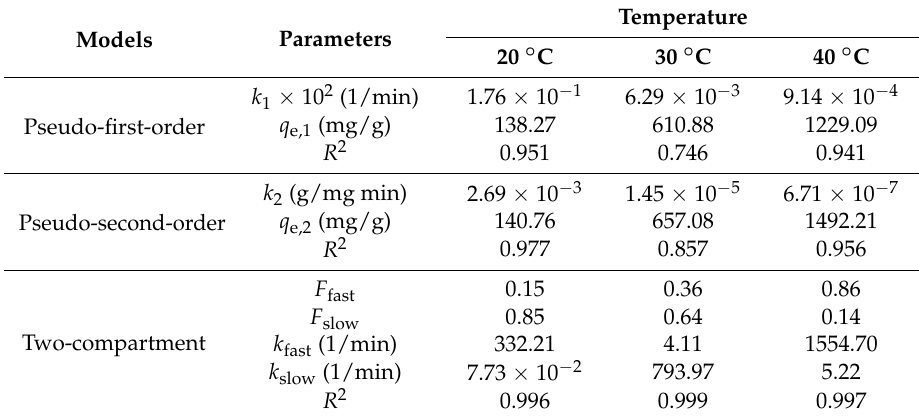
Table 1. Kinetic parameters for adsorption of TC onto Fe 3 O 4